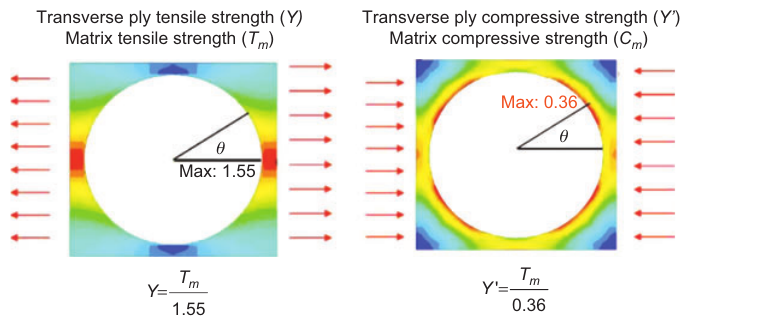
Figure 7 Unit cell transverse compressive and tensile ply strength estimation for typical carbon fi ber/epoxy composites (adapted from Huang et al. [12] ).